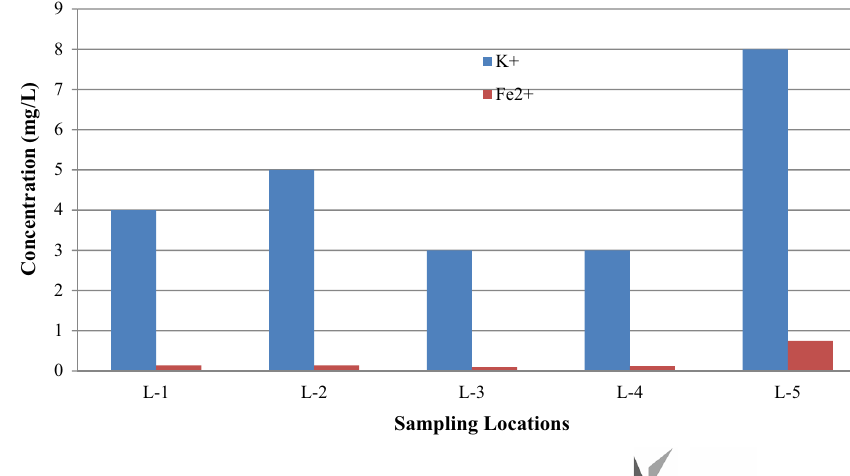
Fig. 6 Variation of K + and Fe 2+ concentrations at different loca- tions of the present